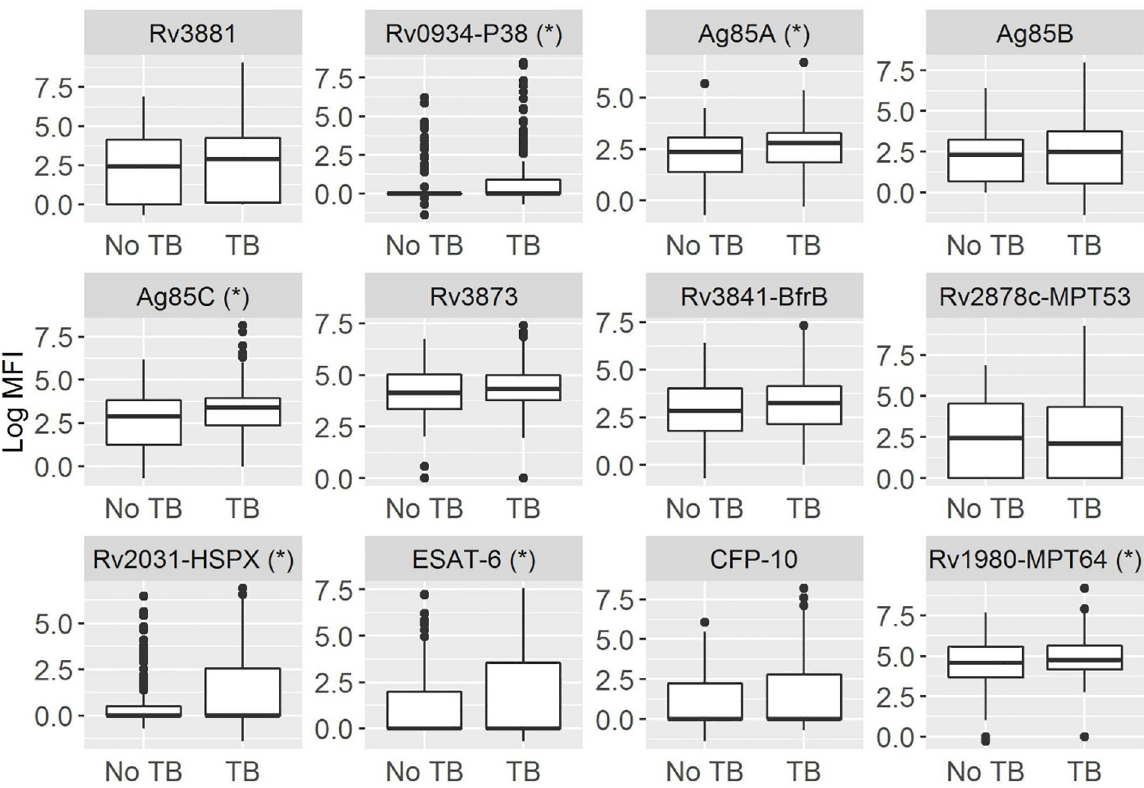
Fig 2. Boxplots of antibody responses to TB antigens by TB status. With a multiplex microbead immunoassay, we compared the log median fluorescence intensity (MFI) among HIV positive adults with and without TB. A star next to the antigen indicates a significant difference by permutation testing (p-value <